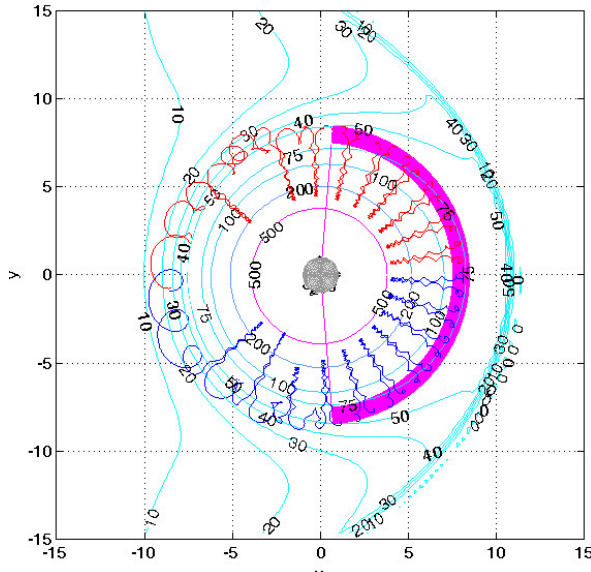
Figure 11. The Lorenz trace of the forwards (blue) and backwards (red) propagating particle is plotted. The region where I is constant according to Fig. 10 is shown in magenta. The contours of constant magnetic field strength are also